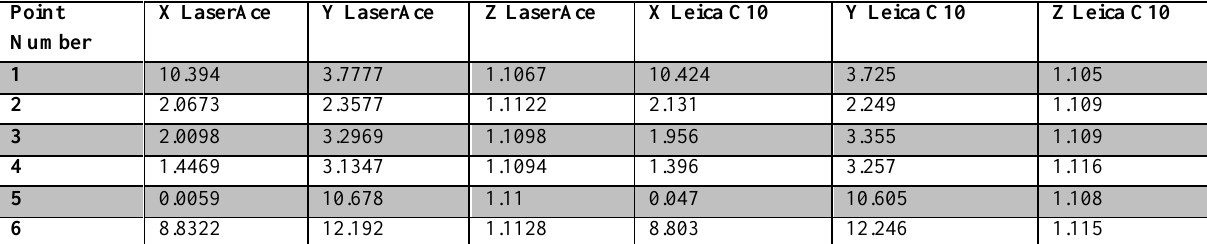
Table 3: LaserAce 1000 calibration based on the least square adjustment (Absolute orientation).